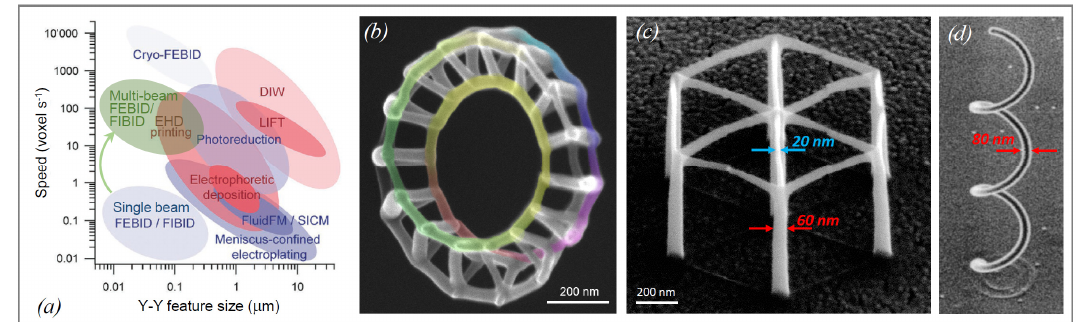
Figure 1. ( a ) Comparison of 3D nanoprinting via focused electron beam-induced deposition (FEBID) and focused ion beam-induced deposition (FIBID) to other sub-10-µm metal additive manufacturing methods within the speed-size parameter space. The acronyms stand for direct ink writing (DIW), electrohydrodynamic printing (EHD), laser-induced forward transfer (LIFT), the electroplating of locally dispensed ions in liquid–atomic force microscopy (AFM), and cantilever-based (FluidFM) and glass capillary-based scanning ion conductance microscope (SICM). The potential of multi-beam versus single beam FEBID / FIBID is indicated. Modified from Hirt et al. [1]. ( b , c ) Examples of 3D FEBID. ( b ) Reprinted from Winkler et al. [7], with the permission of AIP Publishing. ( d ) Example of 3D FIBID structure. Modified from Matsui et al. [8] .